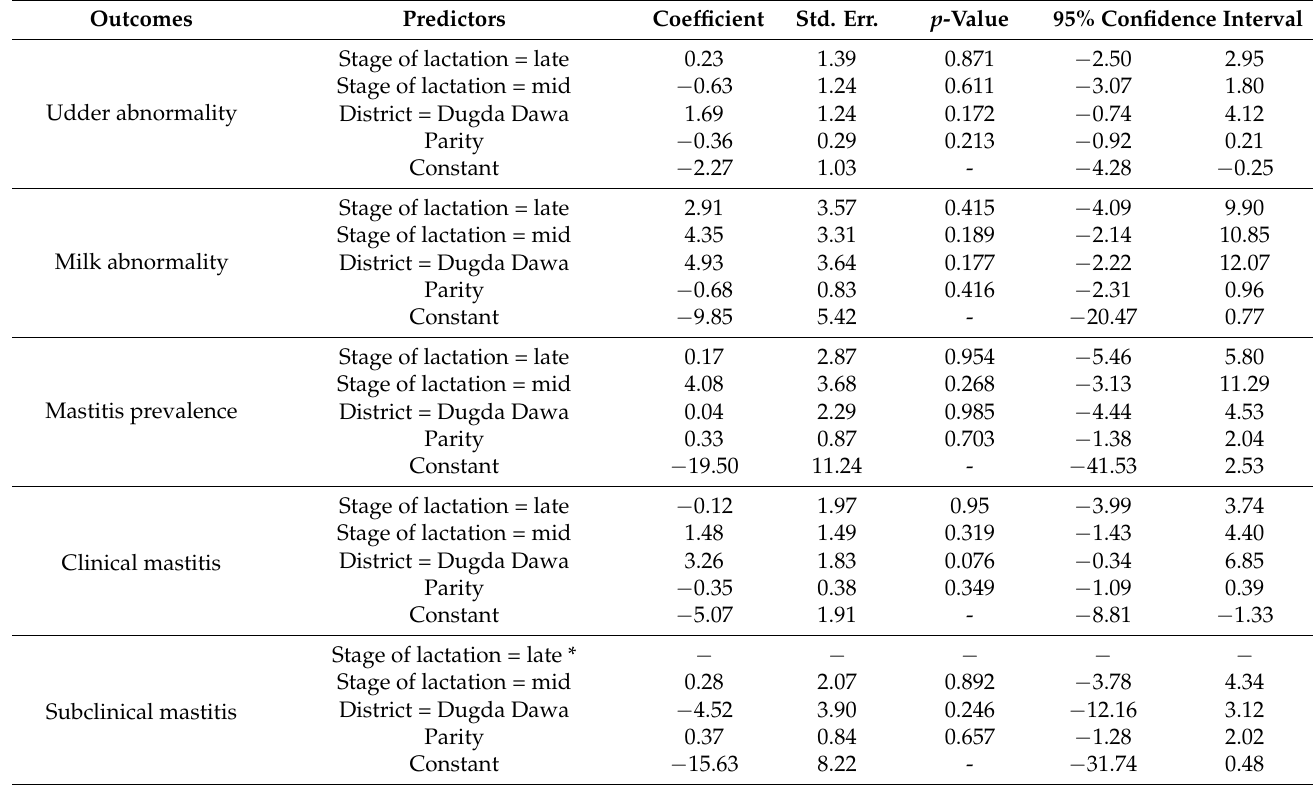
Table 6. Effects of stage of lactation, district, and parity on the prevalence of udder and milk abnormalities, and clinical and subclinical mastitis in dairy goats.